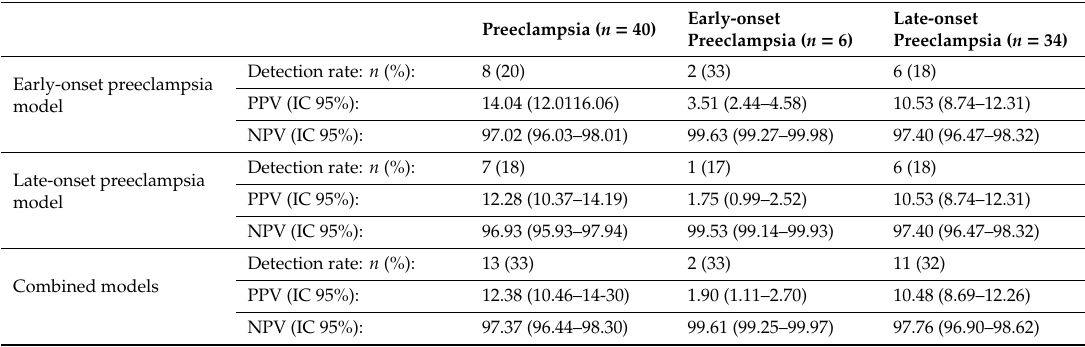
Table 2. Diagnostic performance of di ff erent screening models of preeclampsia in the first trimester of pregnancy, using a fixed false positive rate of 5% ( n =